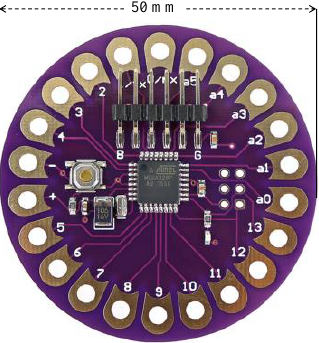
Figure 4. Wearable unit employed in the experiments.